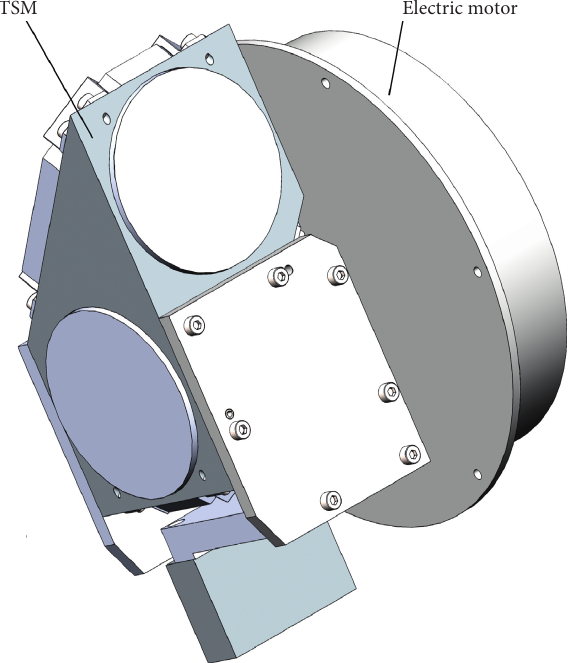
Figure 2: 3D model of the